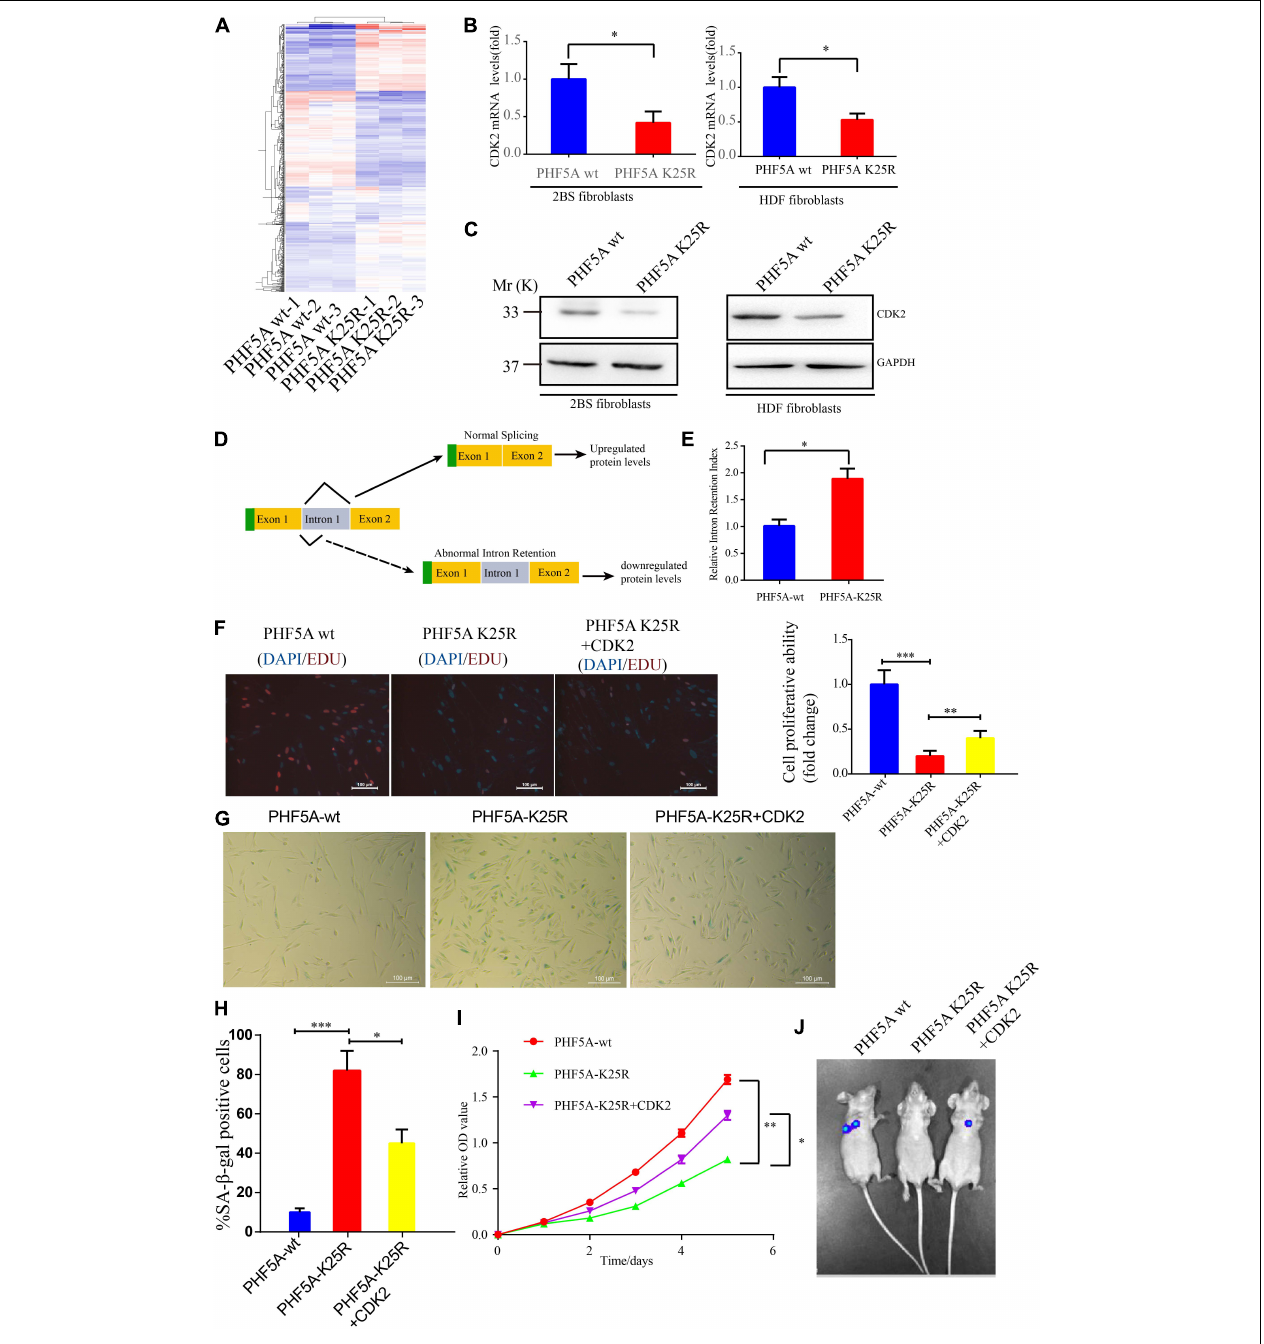
FIGURE 7 | PHF5A K25 decrotonylation accelerates fibroblast senescence by alternative splicing (AS)-mediated downregulation of CDK2. (A) Heat map of differentially expressed genes from RNA-sequencing analysis between PHF5A-WT and PHF5A-K29R cells. PHF5AK29R downregulates CDK2 mRNA and protein levels. (B,C) Quantitative real-time PCR analysis ( n = 3) (B) and immunoblotting analysis of CDK2 in 2BS fibroblast (C) . (D) Schematics of the CDK2 (NM_001798.5) alternative splicing pattern regulated by decrotonylated PHF5A. Full line and dotted line represent normal splicing and abnormal intron retention, respectively. Blue and yellow boxes represent the untranslated region (UTR) and protein-coding region (CDS), respectively. (E) PHF5A K29R increased the CDK2 splicing index for intron 1 retention. Quantitative real-time PCR analysis of normal or abnormal splicing isoforms of CDK2 ( n = 3). (F) EdU incorporation analysis of the proliferative ability of PHF5Awt, PHF5A K25R, and PHF5A K25R+CDK2 2BS fibroblasts, scale bar = 100 µ m. (G,H) SA- β -gal staining analysis of PHF5Awt, PHF5A K25R, and PHF5A K25R+CDK2 2BS fibroblasts, scale bar = 100 µ m. (I) CCK8 analysis of the proliferative ability of PHF5Awt, PHF5A K25R, and PHF5A K25R+CDK2 2BS fibroblasts. (J) The IVIS spectrum imaging system was used to analyze the luciferase activity 4 days after transplantation. All experiments were repeated three times independently, and statistical analysis was performed by t -test, ∗ p < 0.05, ∗∗ p < 0.01, and ∗∗∗ p < 0.01.